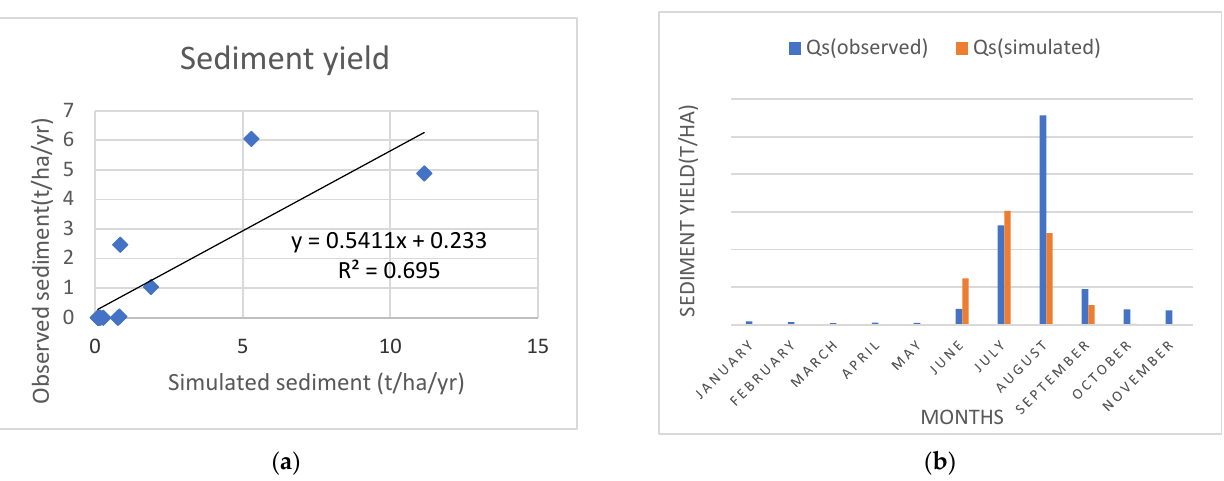
Figure 8. Calibration period (2000–2002). ( a ) Observed versus simulated sediment yield, and ( b ) Monthly sediment yield.